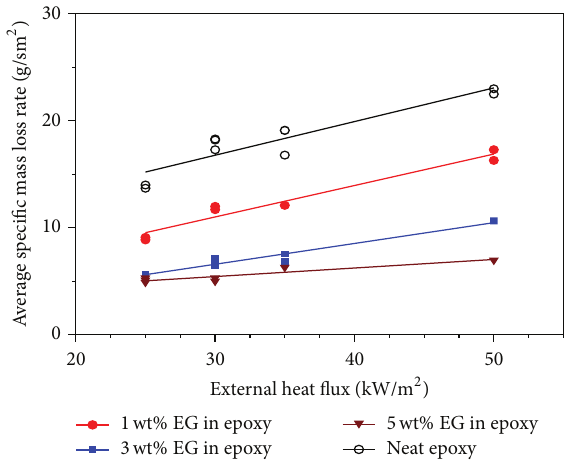
Figure 11: Heat of gasification of the composite samples. The slopes valuesforthesamplesneat,1,3,and5-wt.%EGare0.315,0.294,0.195, and 0.080, respectively.